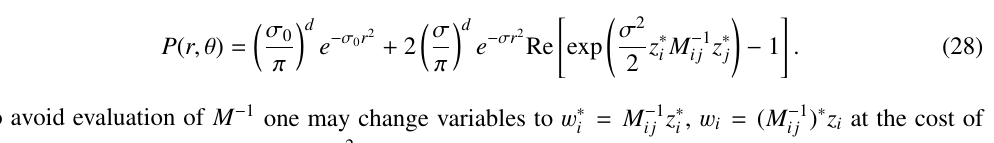
Figure 3. Positive representation of an exponential of ρ ( t ) =